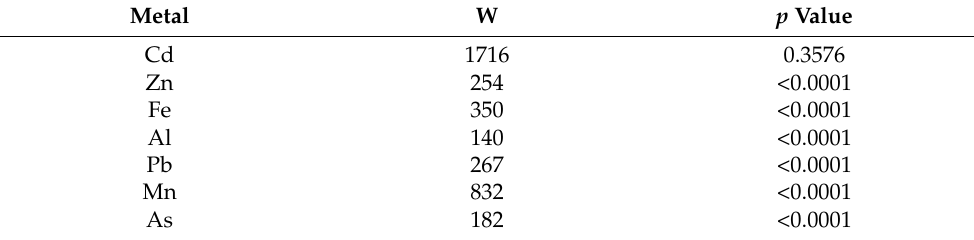
Table 3. Mann–Whitney U test for heavy metal concentrations in Platyhypnidium aquaticum and Marchantia polymorpha